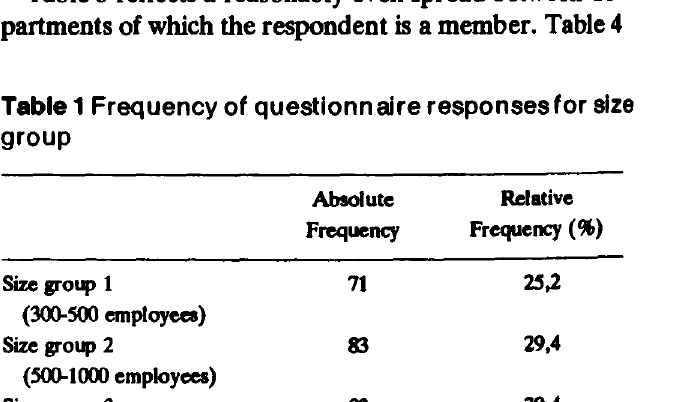
Table 2 Frequency of questionnaire responses for